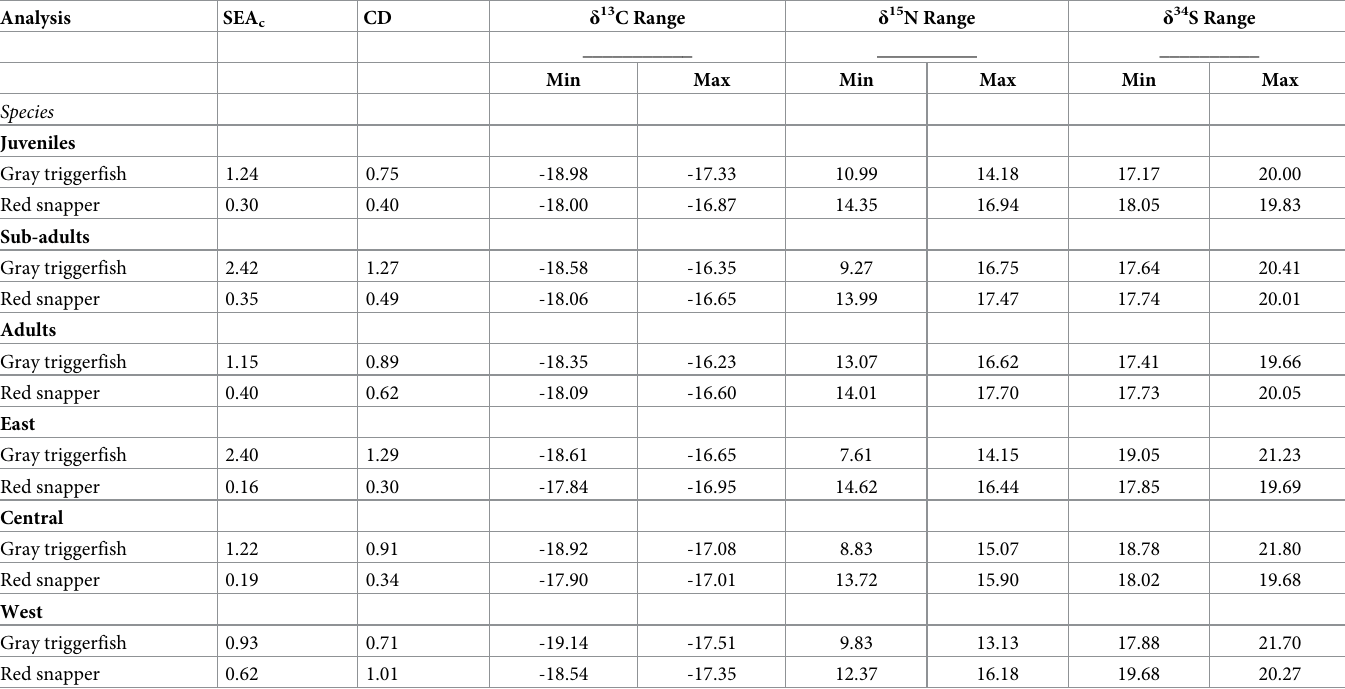
The standard ellipse area (based on δ 13 C and δ 15 N) corrected for sample size (SEA c ) is shown along with mean distance to centroid (CD), and δ 13 C, δ 15 N, and δ 34 S ranges (CR, NR, SR) for each species by size class and region.